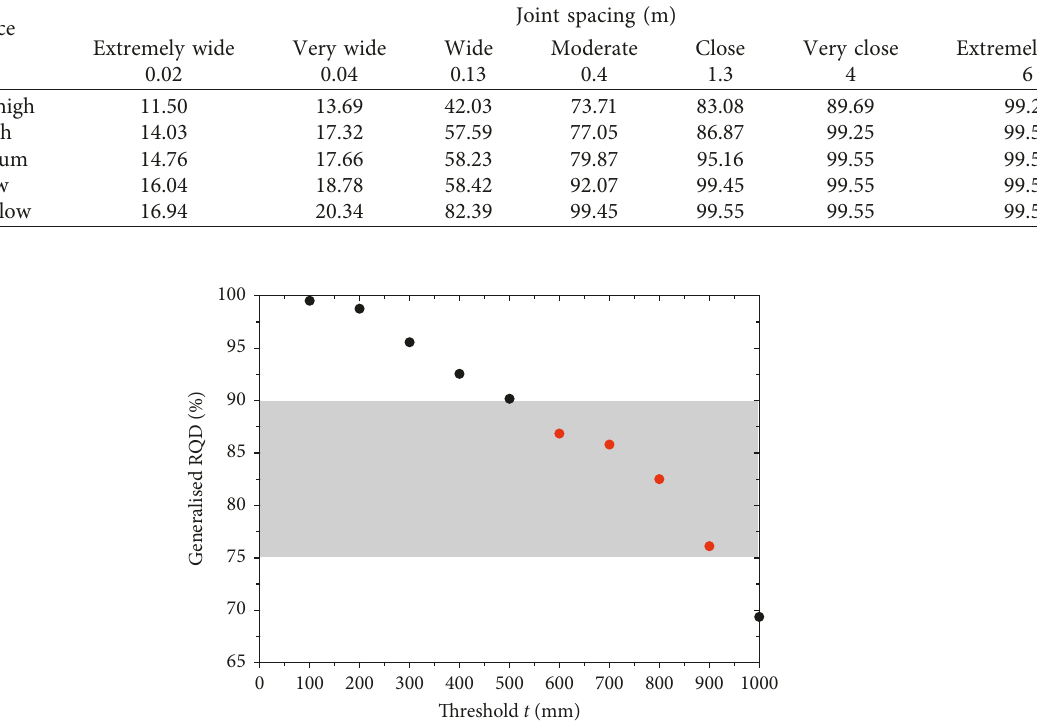
Figure 6: Generalised RQD values with different thresholds of the exampled model.